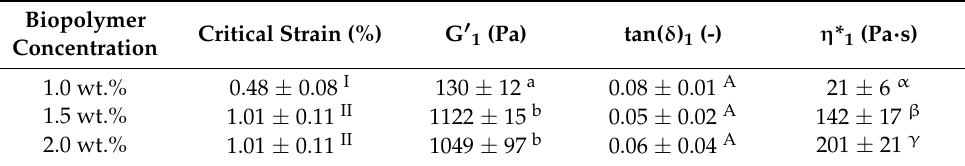
Table 4. Strain and frequency sweep tests parameters (mean value + standard deviation) for chitosan hydrogels with different biopolymer concentrations (1.0, 1.5 and 2.0 wt.%) gelatinized at 4 ◦ C. G (cid:48) 1 :